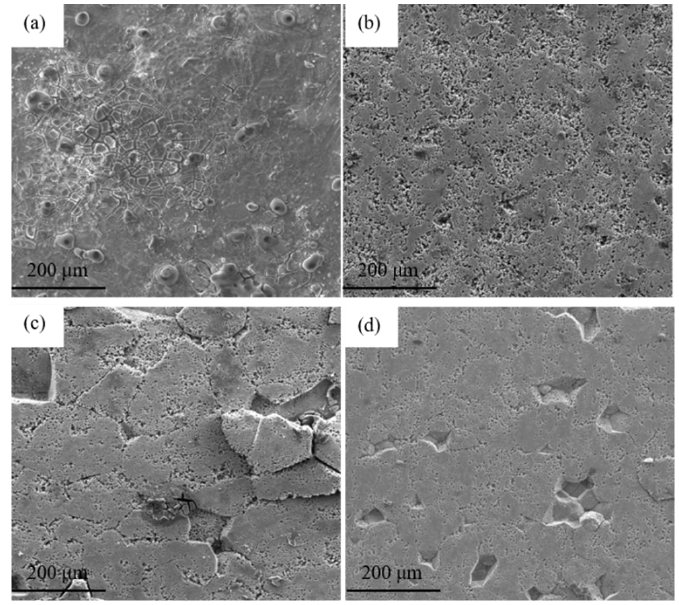
Figure 6. SEM corrosion morphologies of samples after polarization experiments: ( a ) DA; ( b ) 295 °C/100 s; ( c ) 295 °C/800 s; ( d ) 295 °C/1500 s.